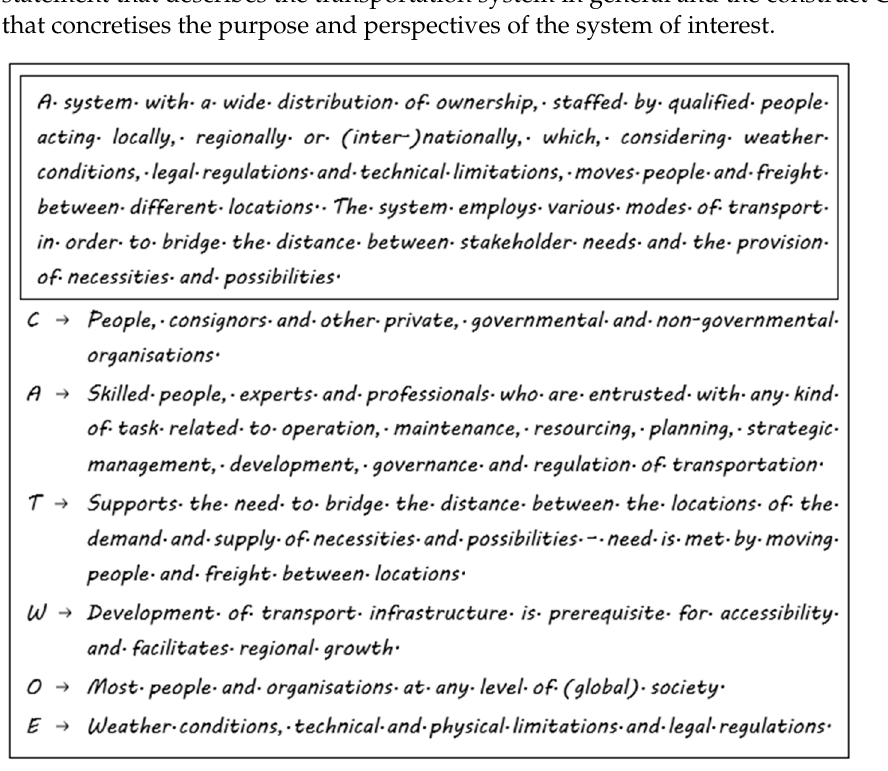
Figure 4. Root definition of the transportation system (originated by the author).